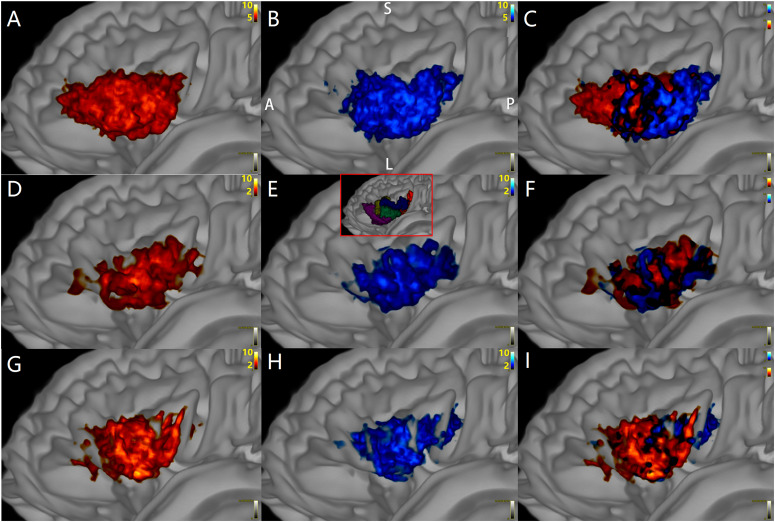
The distributions of target points (red) of Crus–Broca tracts and origin points (blue) of Broca–Crus tracts in Broca’s complex from all subjects. The central area of Broca’s complex is where the majority of target points (red) of Crus–Broca tracts and origin points (blue) of Broca–Crus tracts are located. The posterior part is more involved in Broca–Crus tracts. However, the anterior part is more involved in Crus–Broca tracts. The above-mentioned trend is across all tractography results via DSI Studio (A–C), FSL (D–F), and MRtrix3 (G–I). The inset in (E) demonstrates the locations of five Broca ROIs.